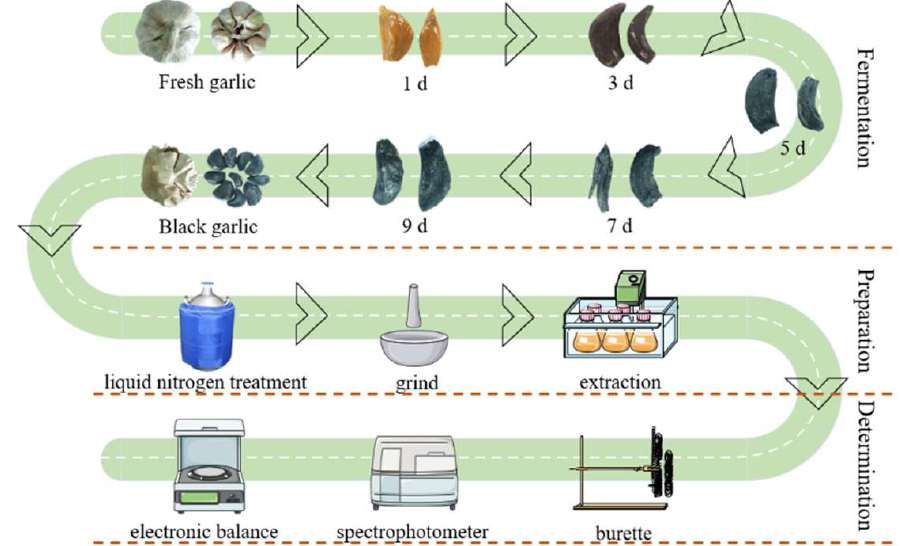
Figure 1. Overall workflow of this study.